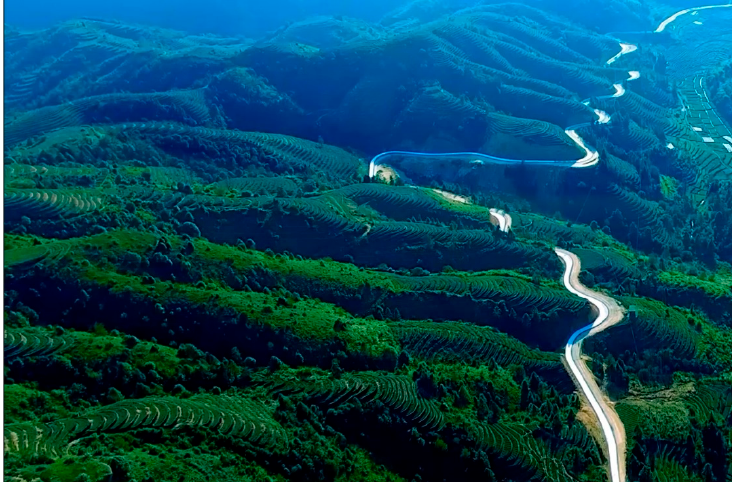
Figure 6. Landscape of Tieguanyin tea garden.